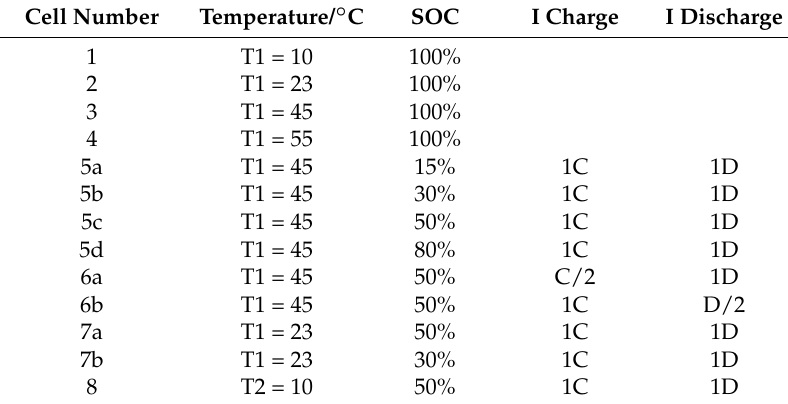
Table 2. Aging test